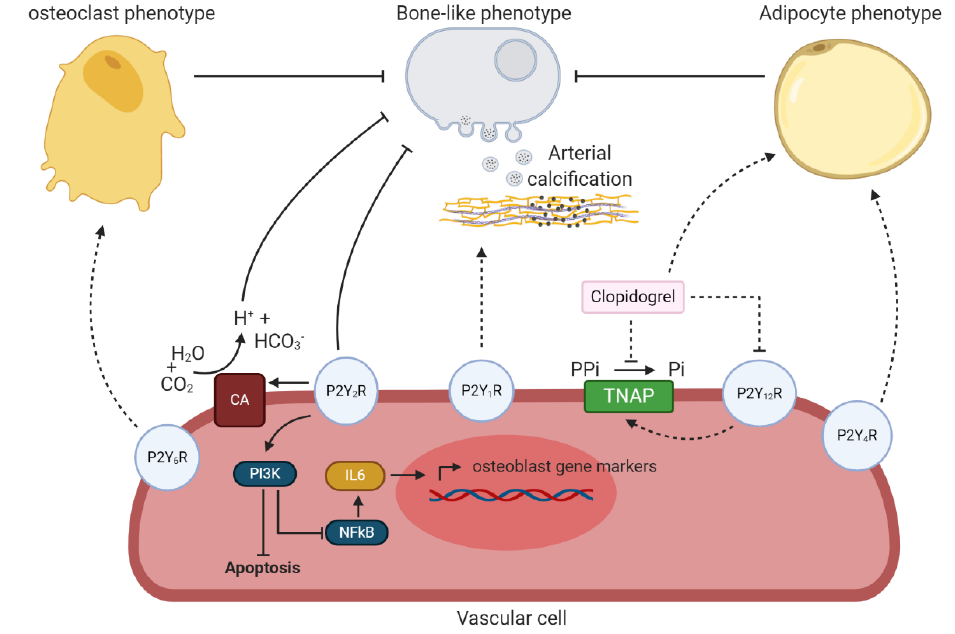
Figure 5. An overview the potential involvement of P2Y receptors in arterial calcification. P2Y 6 receptor might trigger a phenotypic switch of vascular cells towards an osteoclast phenotype and by this prevent arterial calcification. P2Y 2 receptor blocks arterial calcification by (i) stimulating phosphoinositide 3-kinases (PI3K) resulting in a reduction in vascular cell apoptosis and halting the bone-like phenotypic switch of vascular cells via less NFkB signaling and IL6 production and (ii) favoring carbonic anhydrase (CA) expression, catalyzing the reaction of water (H2O) and carbon dioxide (CO2) into hydrogen carbonate (HCO 3− ) and hydrogen ions (H + ) leading to extracellular acidification and thus, resorption of the calcium-phosphate crystals. The P2Y 1 receptor might stimulate the arterial calcification process. P2Y 12 receptor blockage by clopidogrel potentially halts arterial calcification trough inhibition of tissue non-specific alkaline phosphatase (TNAP) and favoring the transdifferentiation of the vascular cell towards an adipocyte phenotype, thus preventing a bone-like phenotypic switch. P2Y 4 receptor might also be involved in the phenotypic switch of vascular cells to an adipocyte phenotype. Dashed lines represent relevant findings in other cell-types, not yet shown in vascular cells. The term vascular cell covers vascular smooth muscle cells and valve interstitial cells. In conclusion, purinergic signaling, as well as ecto-nucleotidases play an indispensable role in the arterial calcification process. Novel therapeutic approaches were developed to treat arterial calcification including selective TNAP and NPP1 inhibitors as well as synthetic ATP analogues (i.e., 2-thioUTP, Bz-ATP, α,β-meATP and β,γ-meATP). Based on the recent literature, these treatments have promising beneficial outcomes on arterial calcification. However, the role of purinergic signaling in the regulation of these processes is by no means fully defined and further in vitro and in vivo studies are warranted to elucidate the mechanisms involved. Moreover, awareness for possible